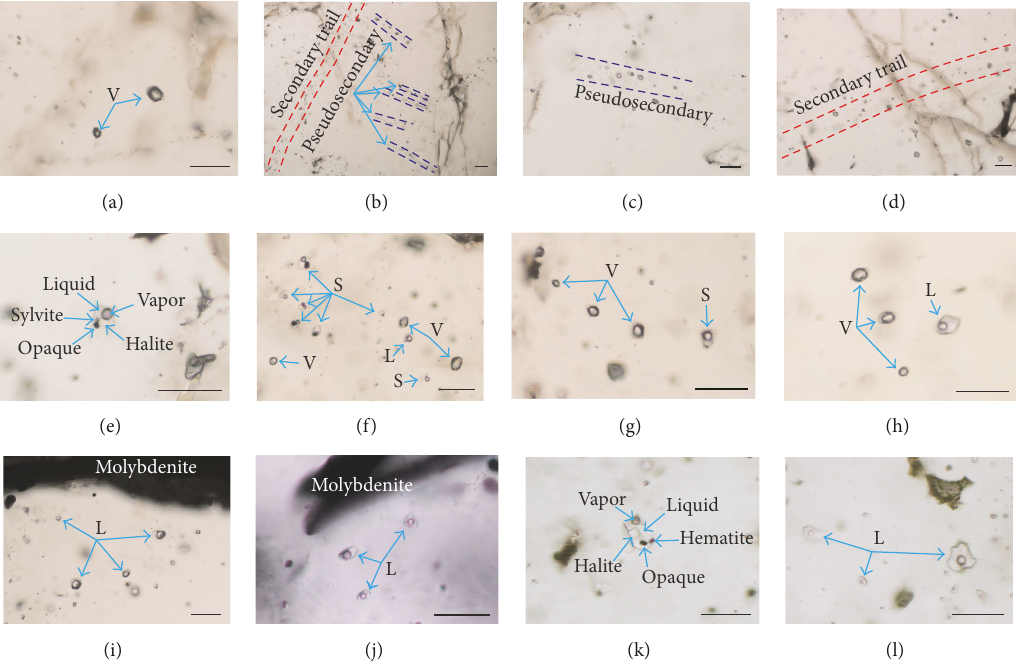
Figure 5: Representative photomicrographs of fluid inclusions hosted in quartz of different hydrothermal stages. (a) Primary V-type fluid inclusions in P-stage quartz. (b) Linear distributed pseudosecondary fluid inclusions (along intragrain fractures) and secondary fluid inclusions (cutting through quartz grain boundaries). (c) Pseudosecondary fluid inclusions along intragrain fractures. (d) Secondary trails of fluid inclusions crosscutting quartz boundaries. (e) A P-stage S-type fluid inclusion containing a liquid phase, a vapor phase, a halite, a sylvite, and an opaque mineral. (f) Coexisting S-type, V-type, and L-type inclusions in P-stage quartz, noting opaque minerals are common in all types of inclusions. (g) Coexisting S-type and V-type inclusions in S-stage quartz. (h) Coexisting L-type and V-type inclusions in